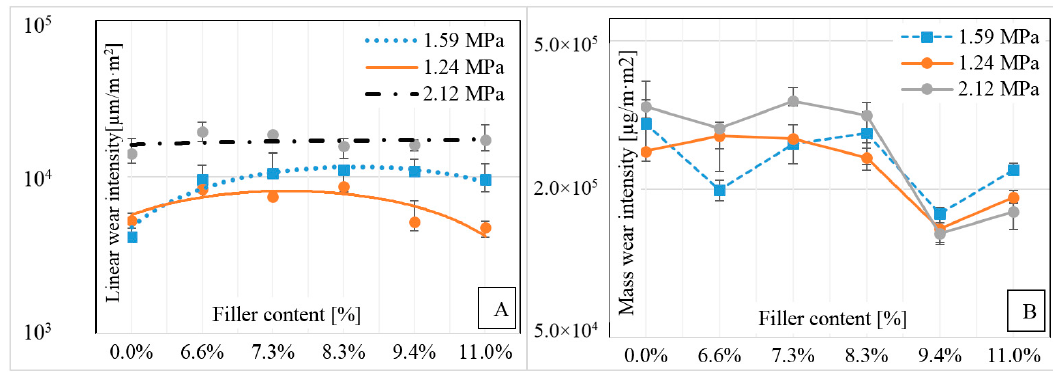
Figure 11. Influence of reinforcing fiber content on ( A ) linear wear intensity, ( B ) mass wear intensity.